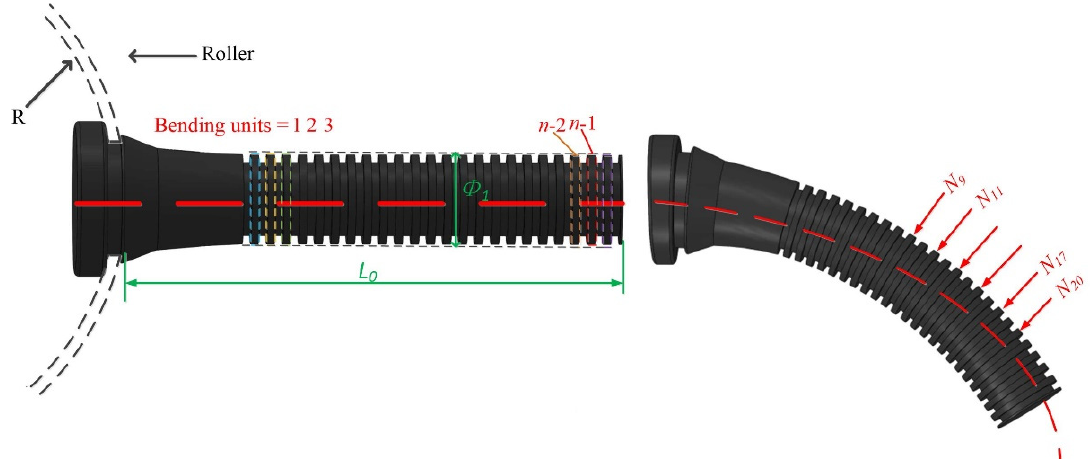
Figure 8. Left flexible finger.